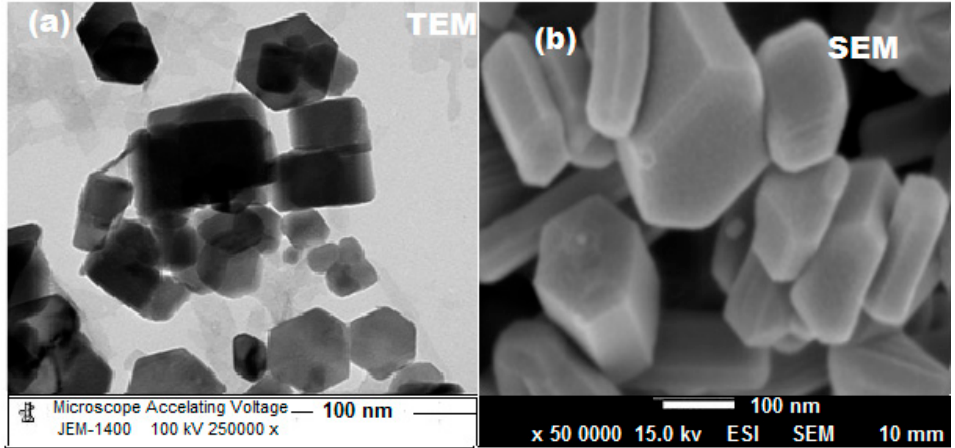
Figure 7. ( a ) Transmission electron microscope (TEM) and ( b ) Scanning electron microscope (SEM) images of ZnONPs.